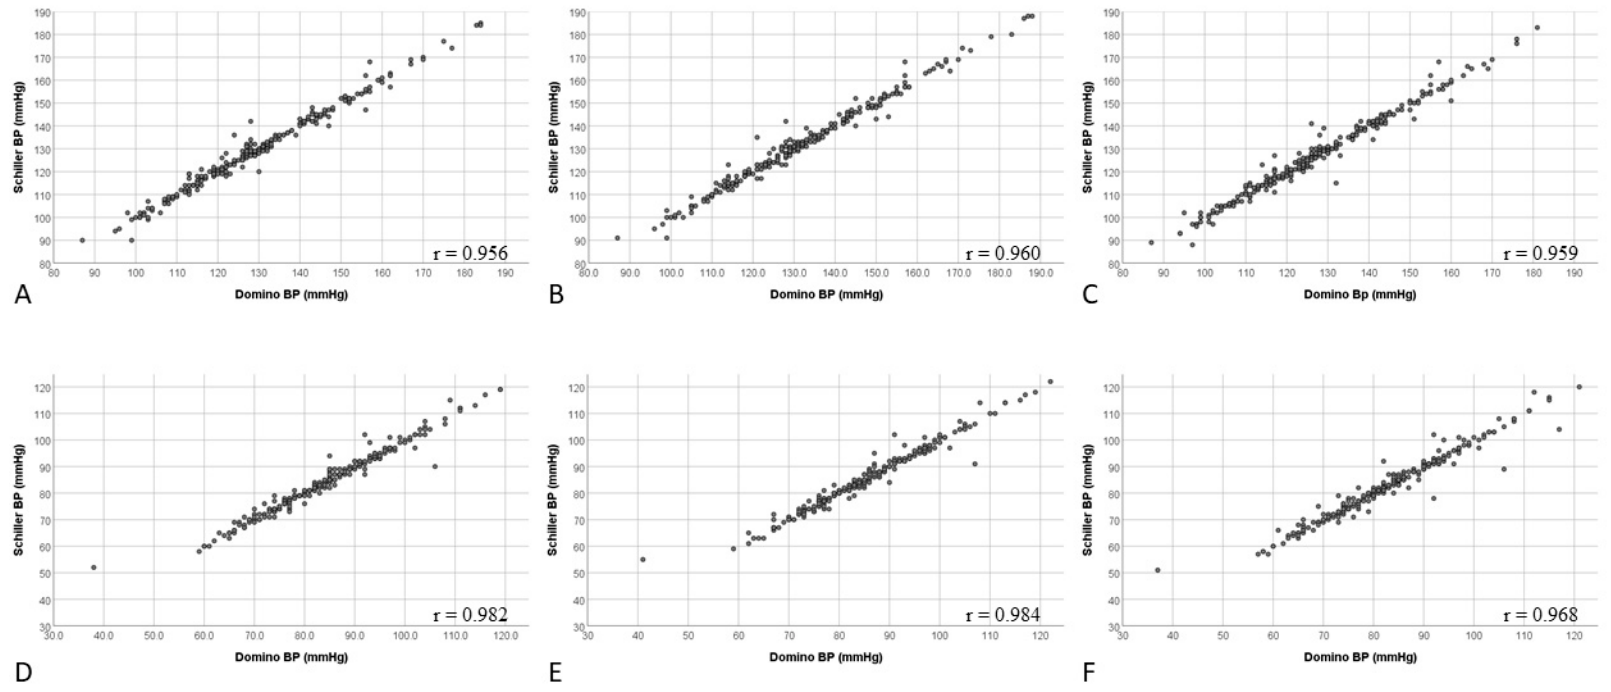
Figure 3. Correlation of systolic and diastolic blood pressure values generated by DominoBP and SchillerBP software for 24-hour, awake, and asleep blood pressure measurements. ( A ) 24-hour systolic measurements, ( B ) awake systolic measurements, ( C ) asleep systolic measurements, ( D ) 24-hour diastolic measurements, ( E ) awake diastolic measurements, ( F ) asleep diastolic measurements.